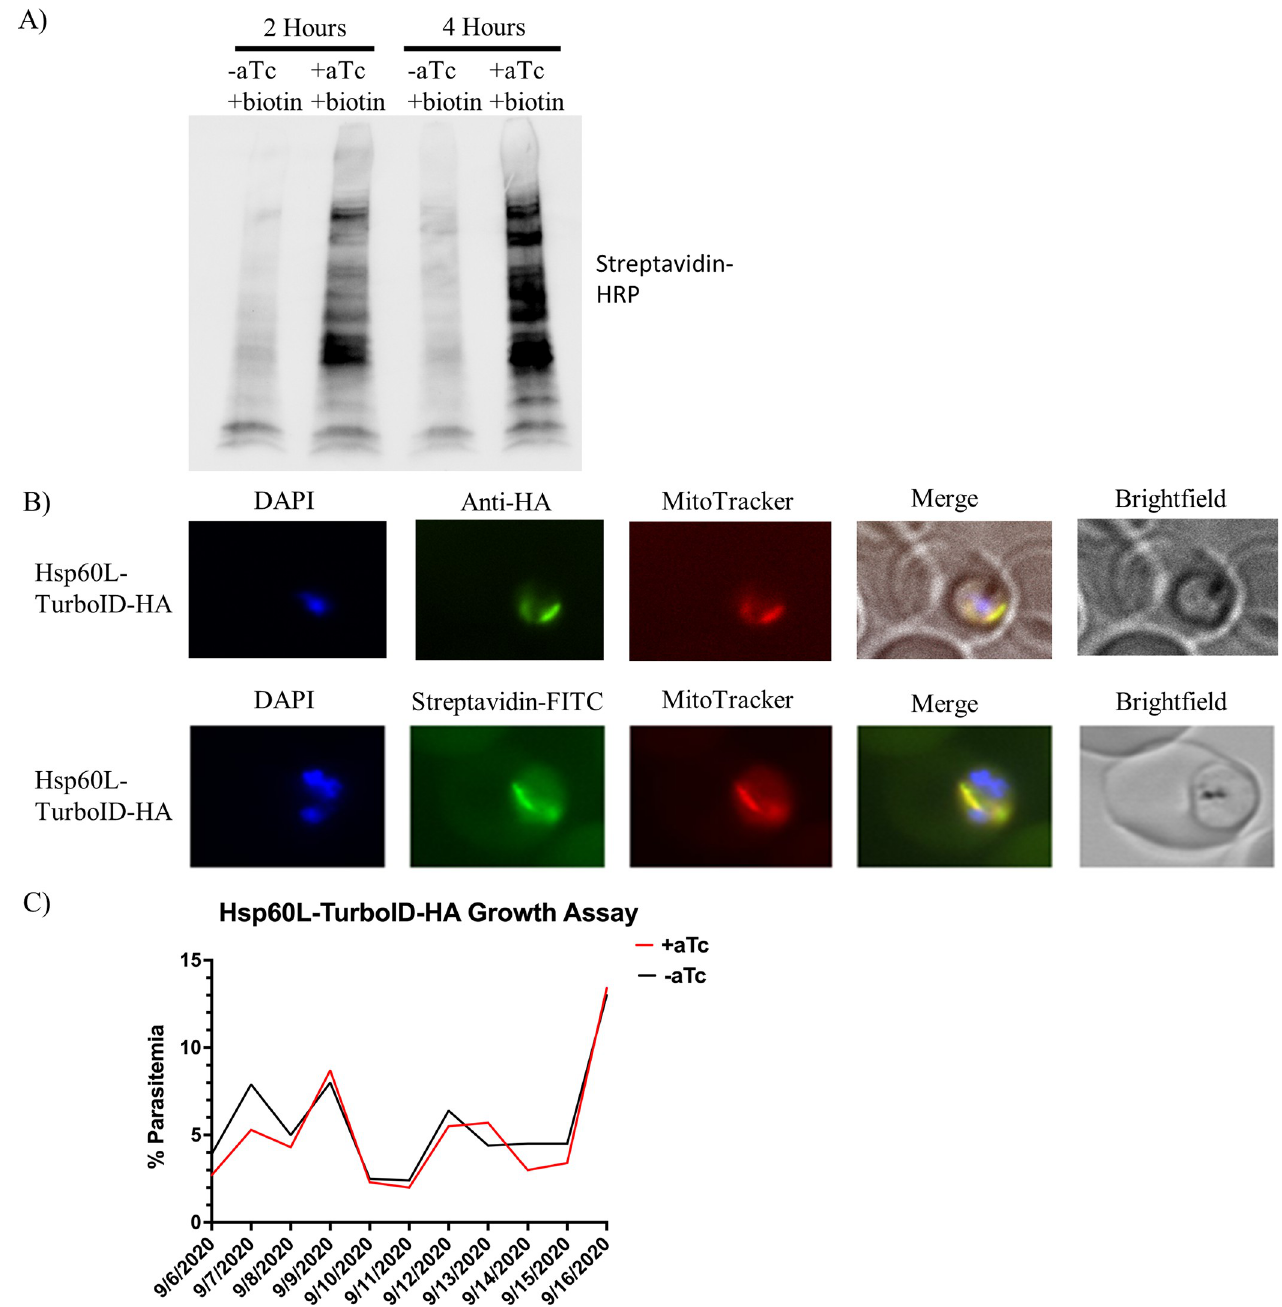
Fig 2. Characterization of pMG75BB-8XAptamer-TurboID-3xHA parasite line. A) Western blot analysis of equal numbers of parasites grown in aTc - / biotin + or aTc + /biotin + for a period of 2 or 4 hours. 75 μ g of total protein for each sample were loaded. The blotted PVDF membrane was probed with streptavidin-HRP. Note the time-dependent increase in biotinylated proteins between hours 2 and 4 in the aTc + biotin + condition. B) Indirect immunofluorescence assay using an anti-HA antibody in aTc + medium to confirm mitochondrial localization of Hsp60L-TurboID-3xHA and an immunofluorescence assay using a streptavidin-FITC conjugate. For this assay, parasites were grown in aTc + medium and incubated with 150 μ M biotin for 1 hour. Note the overlap between biotinylated proteins and Mito-Tracker staining. C) Hsp60L-TurboID growth assay. Parasites were split equally to maintain healthy parasitemia. Giemsa-stained slides were made daily for 11 days. Parasitemia was determined each day by counting the number of infected red blood cells per 1,000 red blood cells per slide.